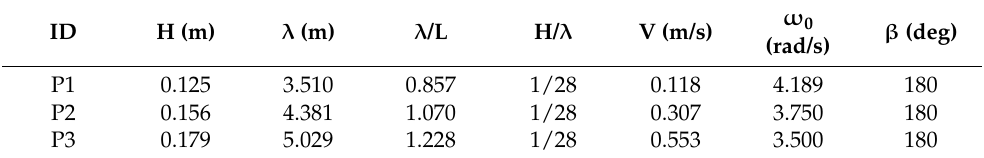
Table 7. The simulation conditions for case P1, P2, and P3.